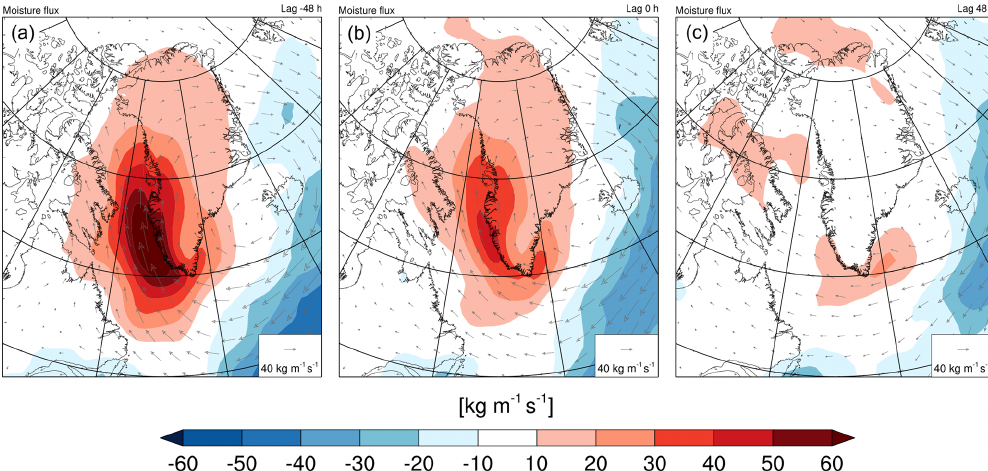
Figure 9. Median composites of total column horizontal water vapor transport anomalies (TCVHT (cid:48) ) with respect to climatology for different lags relative to melt event time steps: (a) lag = − 48h, (b) lag = 0h, and (c) lag = + 48h.